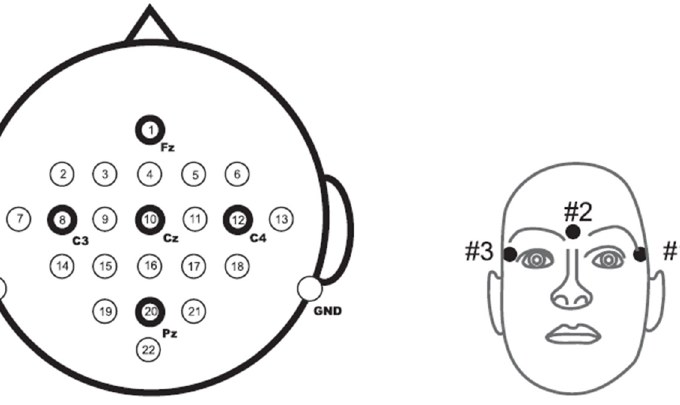
Figure 3. From BCI Competition IV dataset 2a, one trial timing scheme is provided for the MI experimental paradigm based on EEG [41]. 3.2. Preprocessing Stage Because the MI-based BCI was contaminated by so many different artifacts (Figure 4), conventional filtering and the independent component analysis (ICA) techniques have been used as described in the following sections.